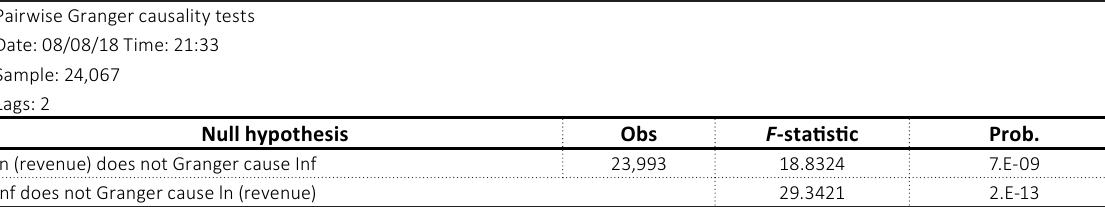
Table A7. Granger causality